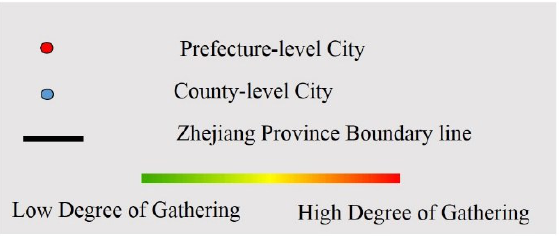
Figure 3. The Gathering Map of the Culture Resources Density and Districts in Zhejiang Province